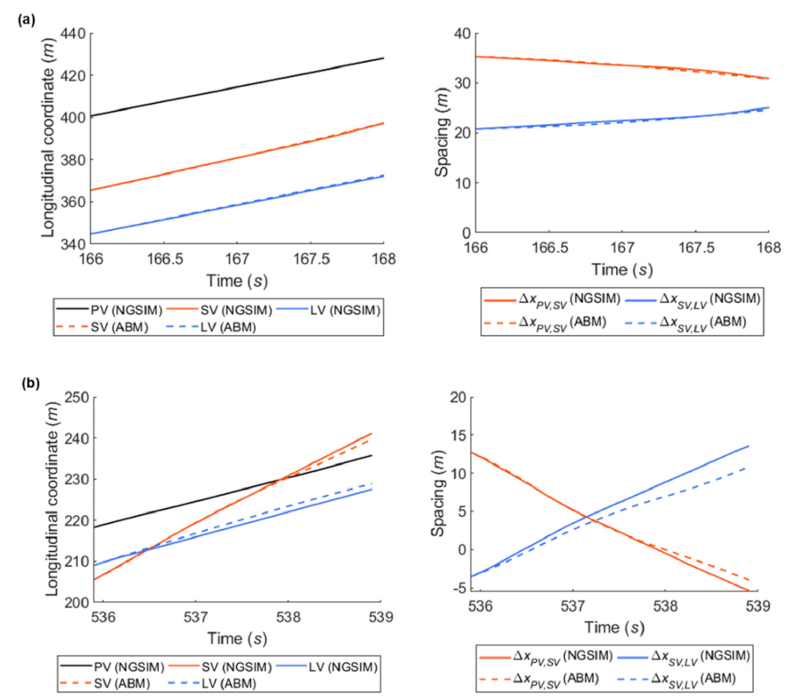
Figure 14. Simulation model validation results based on the graphical comparison method: ( a ) changing situation (SV ID: 268, PV ID: 258, and LV ID: 269 in the US101 data collected from 8:05 to 8:20 a.m.) and ( b ) overtaking situation (SV ID: 1108, PV ID: 1112, and LV ID: 1118 in the US101 data collected from 8:20 to 8:35 a.m.).